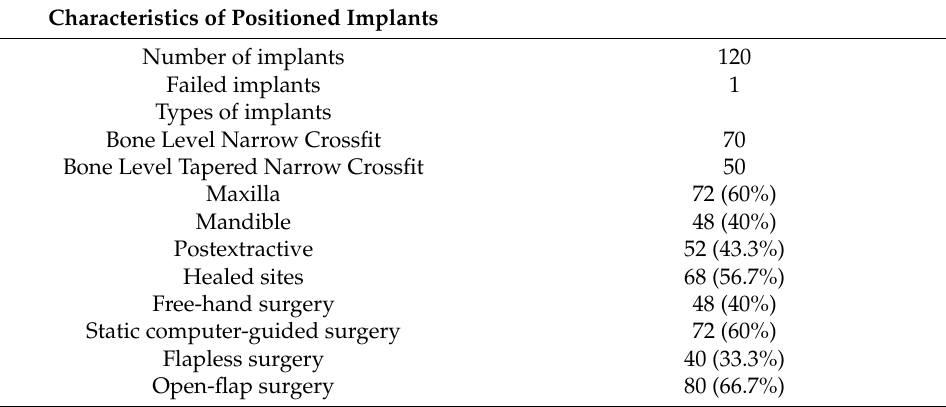
Table 3. Characteristics of positioned implants. Characteristics of Positioned Implants Number of implants